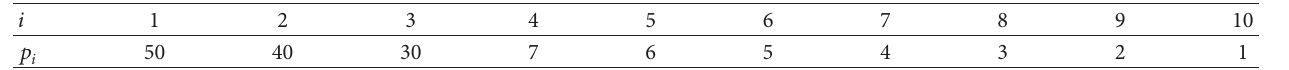
Table 2: The 10 jobs processing